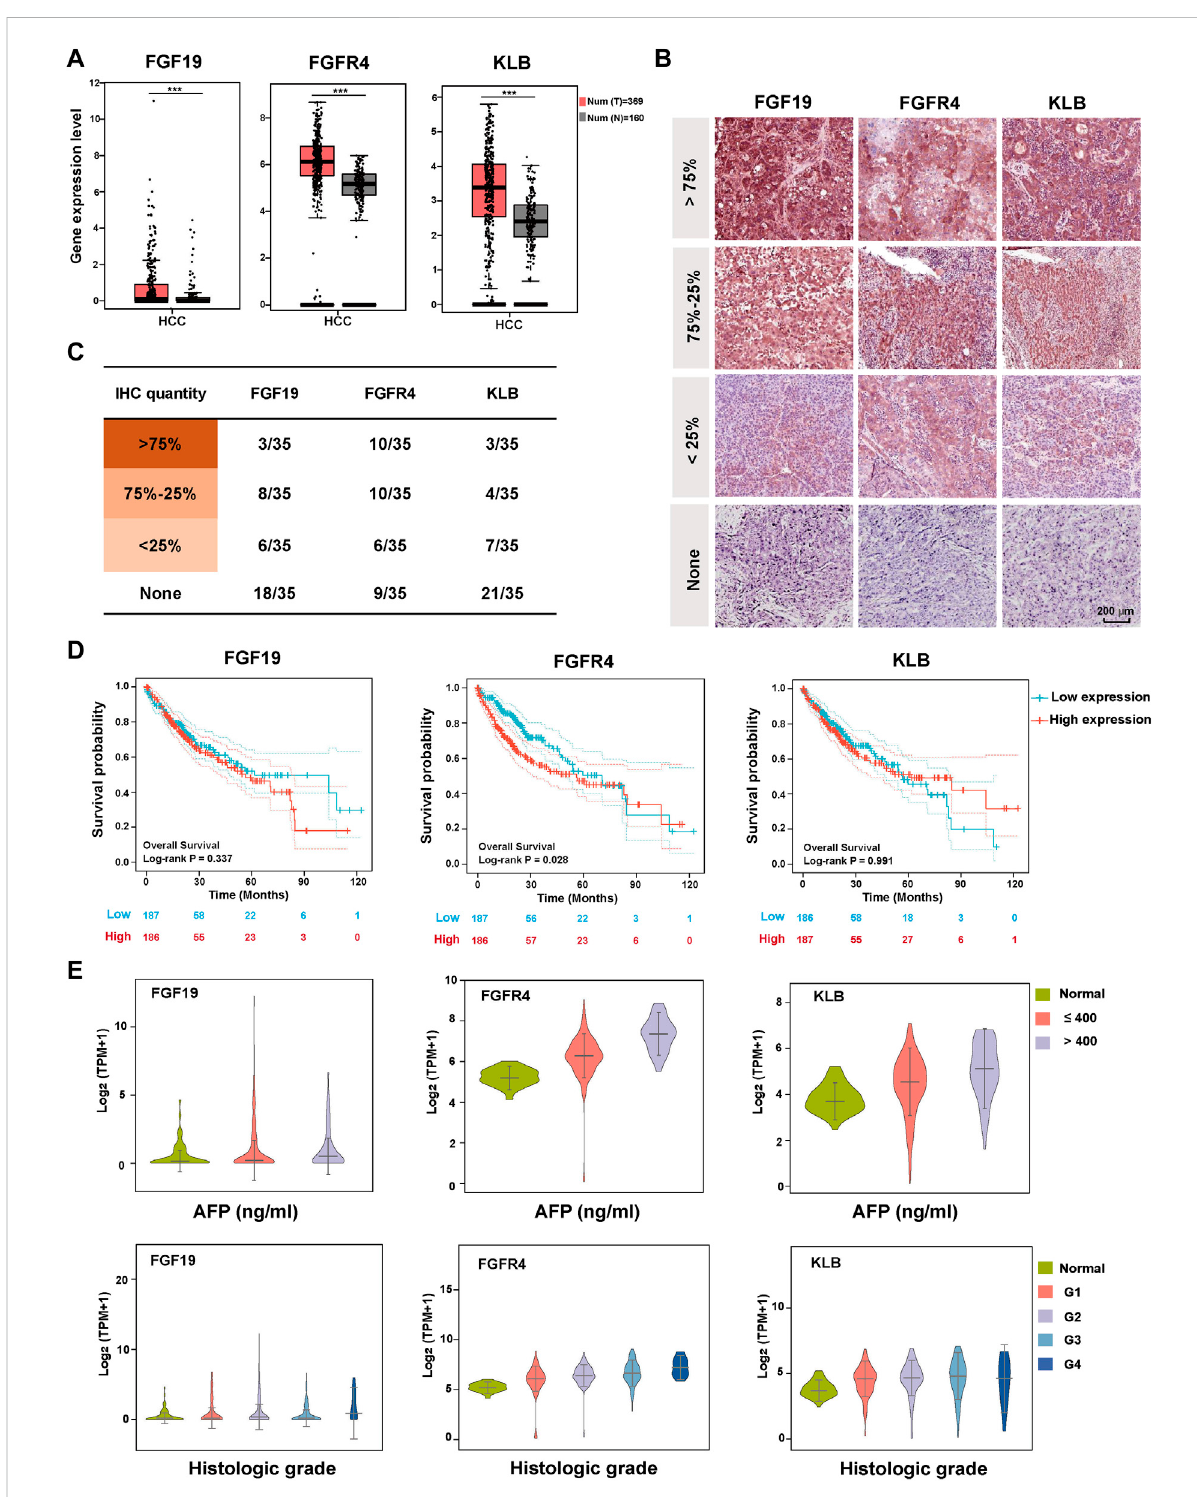
FIGURE 1 Expression and clinicopathological characteristics of FGF19-FGFR4-KLB axis in HCC. (A) The expression levels of FGF19, FGFR4, and KLB transcripts (TPM) in 369 cancer tissues (red) and 160 normal tissues (gray) of HCC patients. (B) Representative pictures showing the expression level ofFGF19,FGFR4,andKLBproteinevaluatedbyIHCinHCCtissues. (C) ThestatisticalnumberofIHCFGF19,FGFR4,andKLBproteinexpressionlevels inHCC tissues. (D) The overall survivalcurveofHCC patients inthehigh and low expression groups of FGF19, FGFR4, and KLB, withthemedian as the cutoff point. (E) The relationship between the expression levels of FGF19, FGFR4, and KLB Log 2 (TPM+1) and the clinicopathological characteristics (AFP level and Histological grade) of HCC in TCGA database. * p -value < 0.05, ** p -value < 0.01, *** p -value < 0.001, **** p -value <